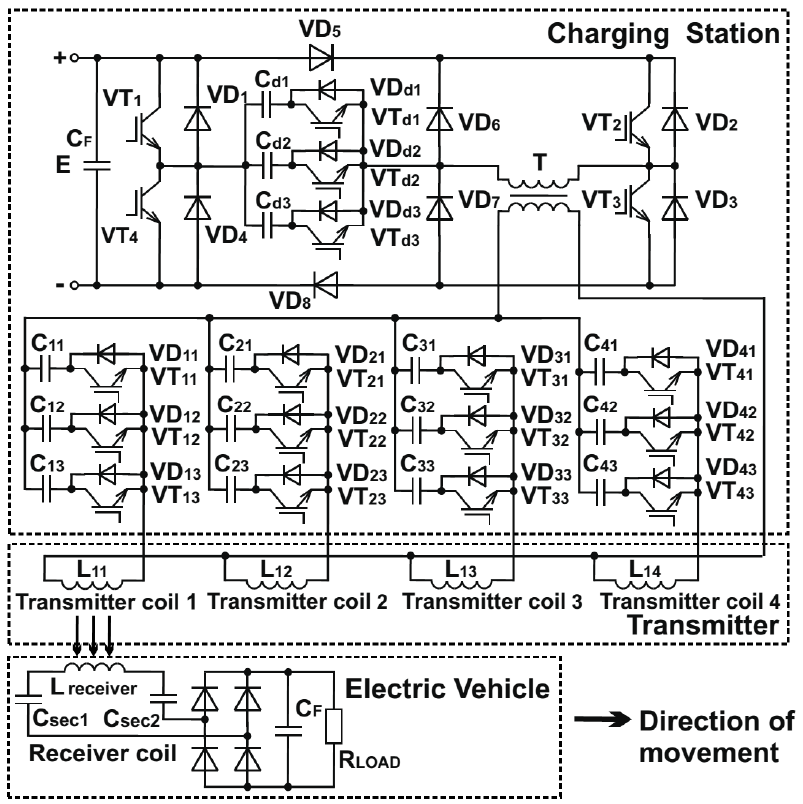
Figure7. Figure 7. Proposed autonomous inverter with energy dosing (AI with ED) and dynamic matching circuit.